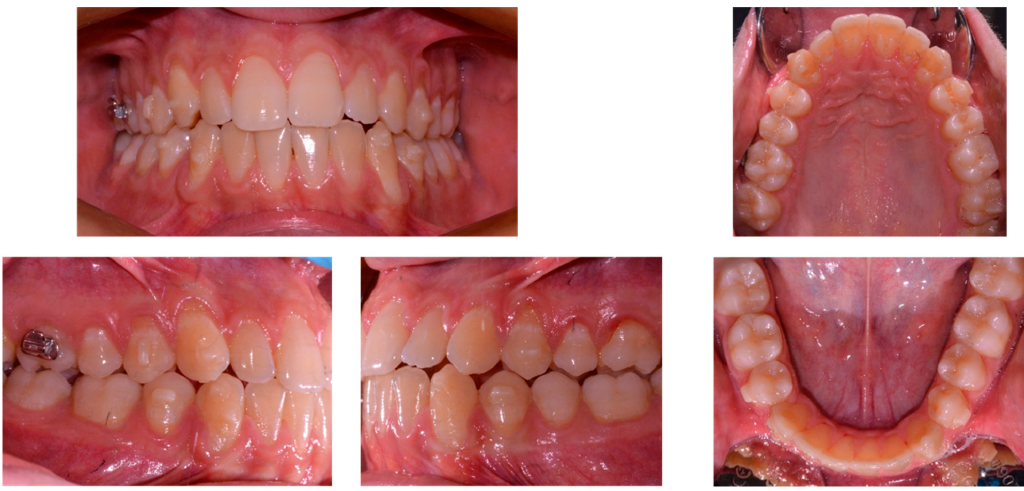
Figure 4. Intraoral records before refinement phase.